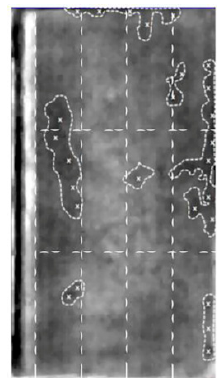
Figure 5. Kurtogram result pointed out by a segmentation procedure. White grid lines indicate the L n -sections used for performing NMR measurements.